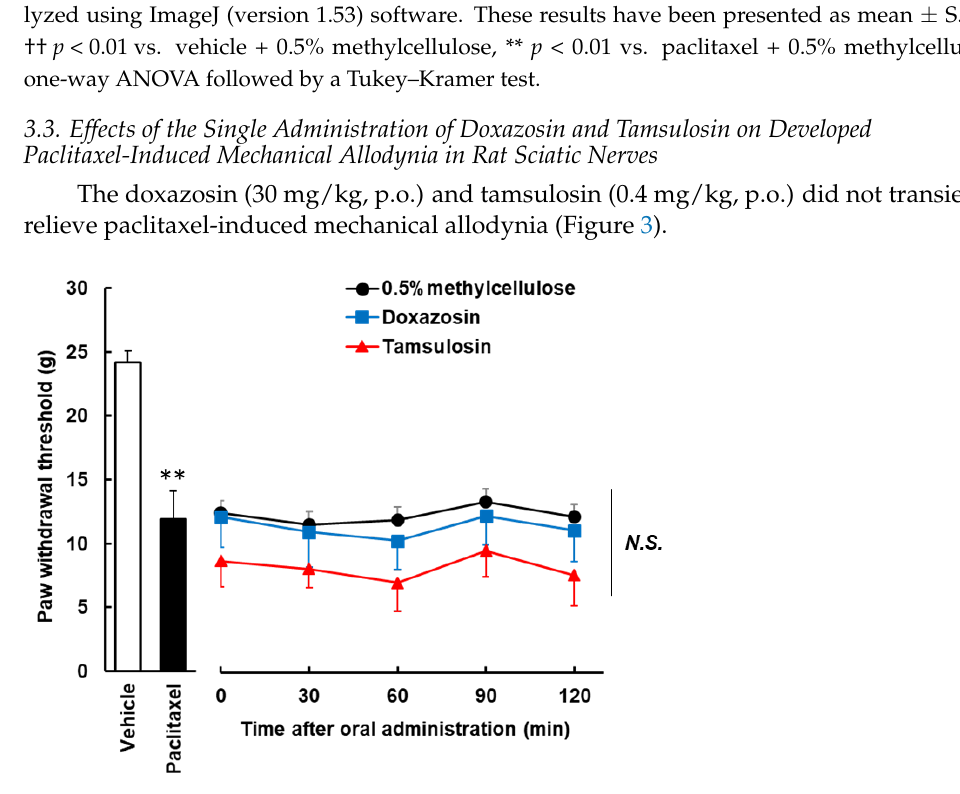
Figure 3. Effects of single administration of doxazosin and tamsulosin on developed paclitaxel-induced mechanical allodynia in the von Frey test. Paclitaxel (6 mg/kg) was administered intraperitoneally once weekly for 4 weeks. Doxazosin (30 mg/kg) and tamsulosin (0.4 mg/kg) were administered orally as a single dose after the development of allodynia due to paclitaxel administration. Threshold values were determined to be mean ± S.E.M. ( n = 8). ** p < 0.01 vs. vehicle, Student’s t test.